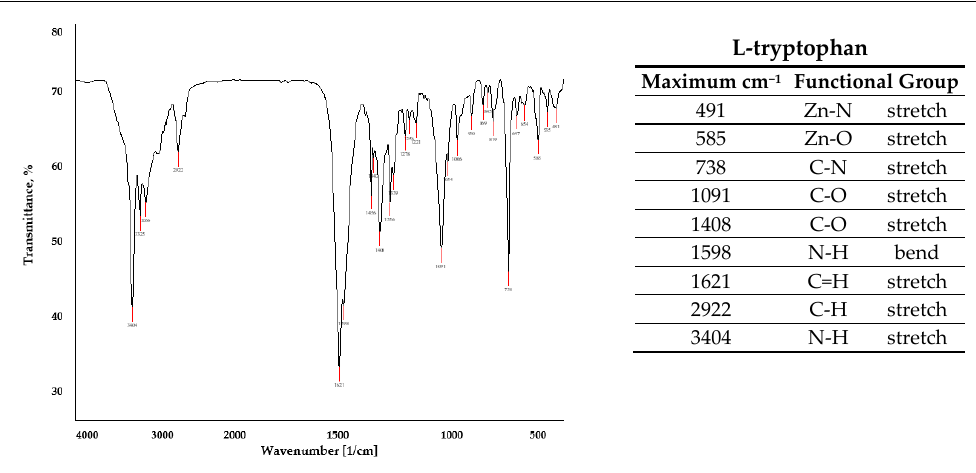
Figure 13. FTIR spectra of tested inhibitors on galvanized steel samples in fresh water.